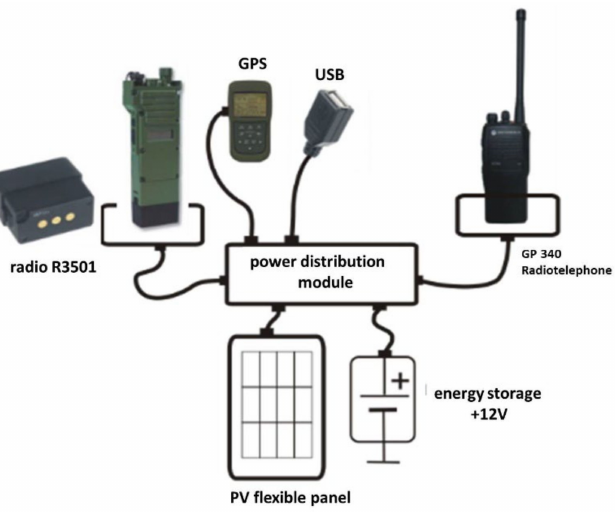
Figure 5. Block diagram of the personal power device (source, prepared by the